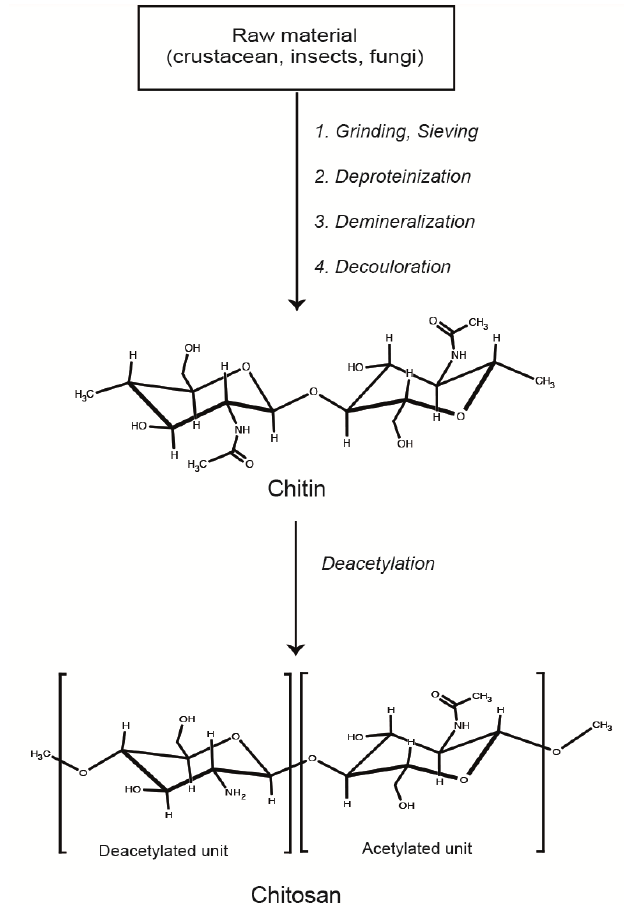
Figure 1. Schematic representation of low molecular weight chitosan (LMWC) manufacturing